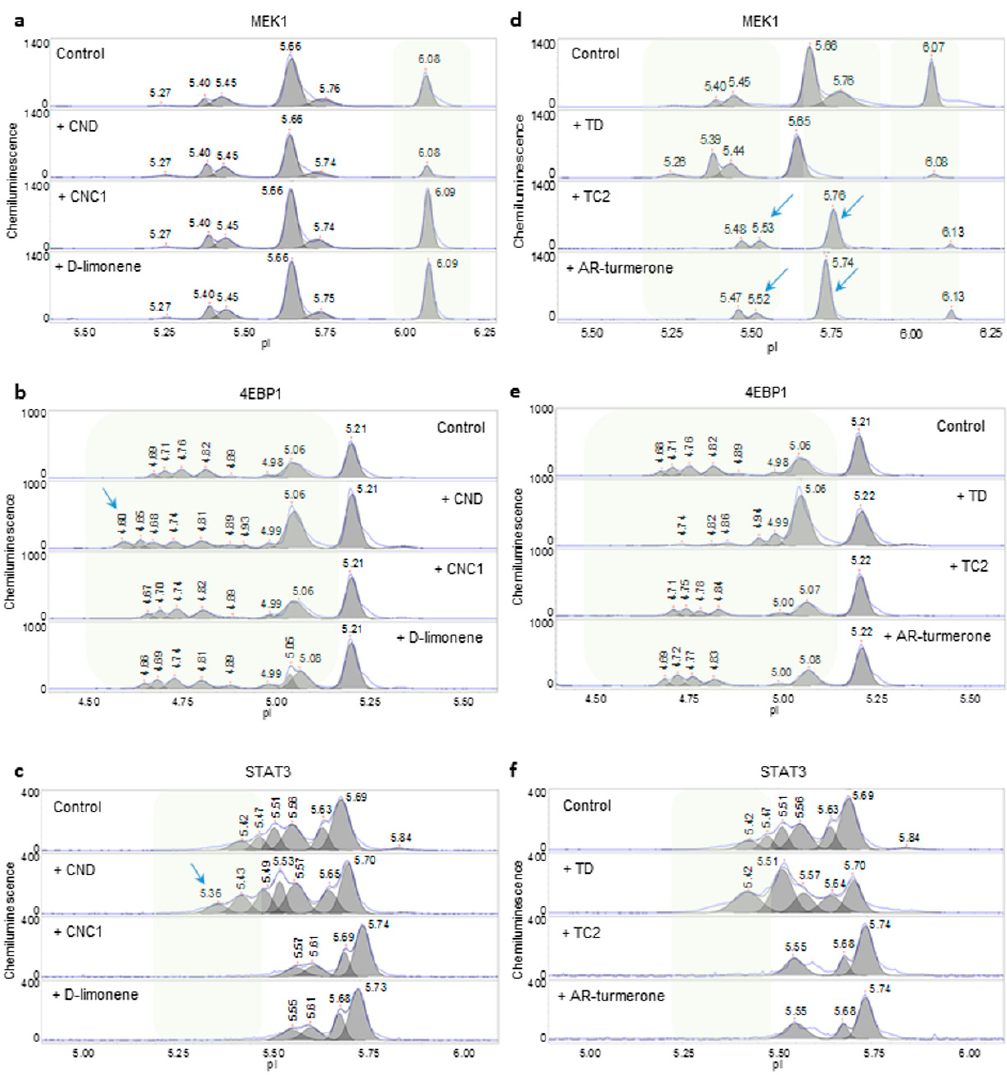
Figure 3. Assessment of the quality of mandarin and turmeric essential oils. ( a–c ) Phosphorylation